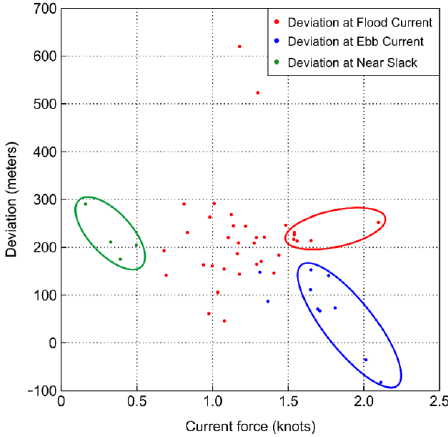
Figure 10. Distribution of tidal strength and deviation at all